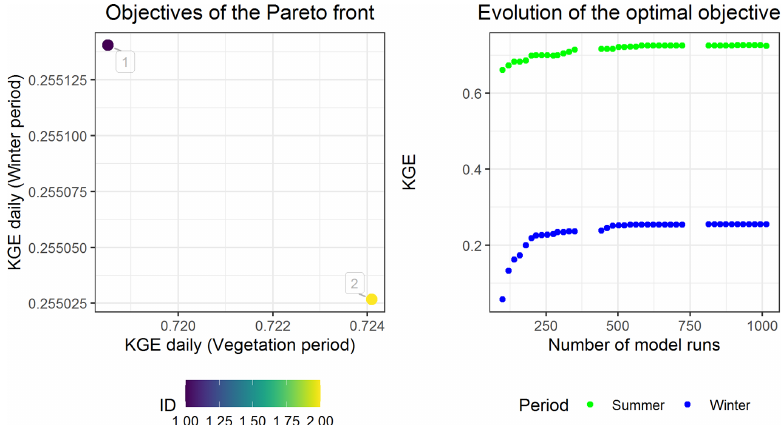
Figure C4. Resulted calibration Pareto fronts for Tharandt (chosen ID – 2).